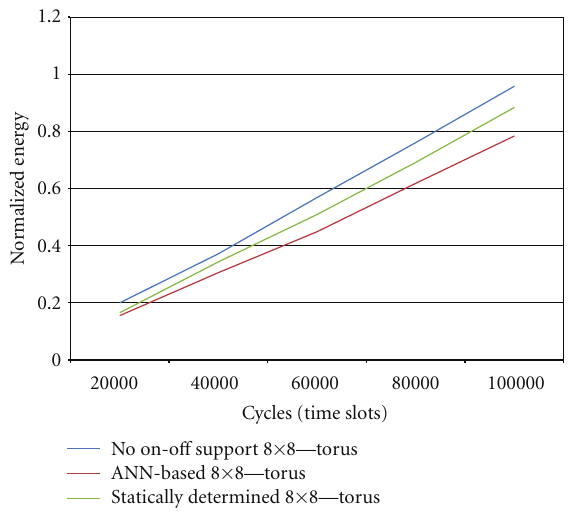
Figure 11: Energy consumption for a 8 × 8 mesh network.